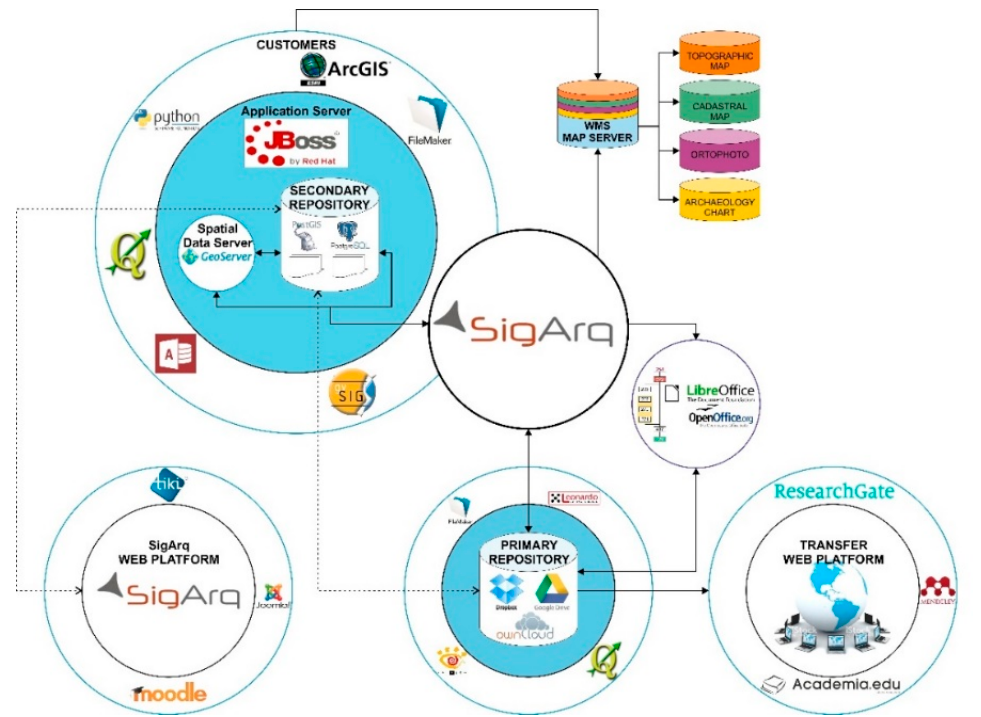
Figure 5. General design of SigArq ARIS as a system of subsystems. Different software can address and exploit text, graphic, cartographic, and relational data contained in linked repositories in order to produce reports and files used as a reflection of Constructed Past.